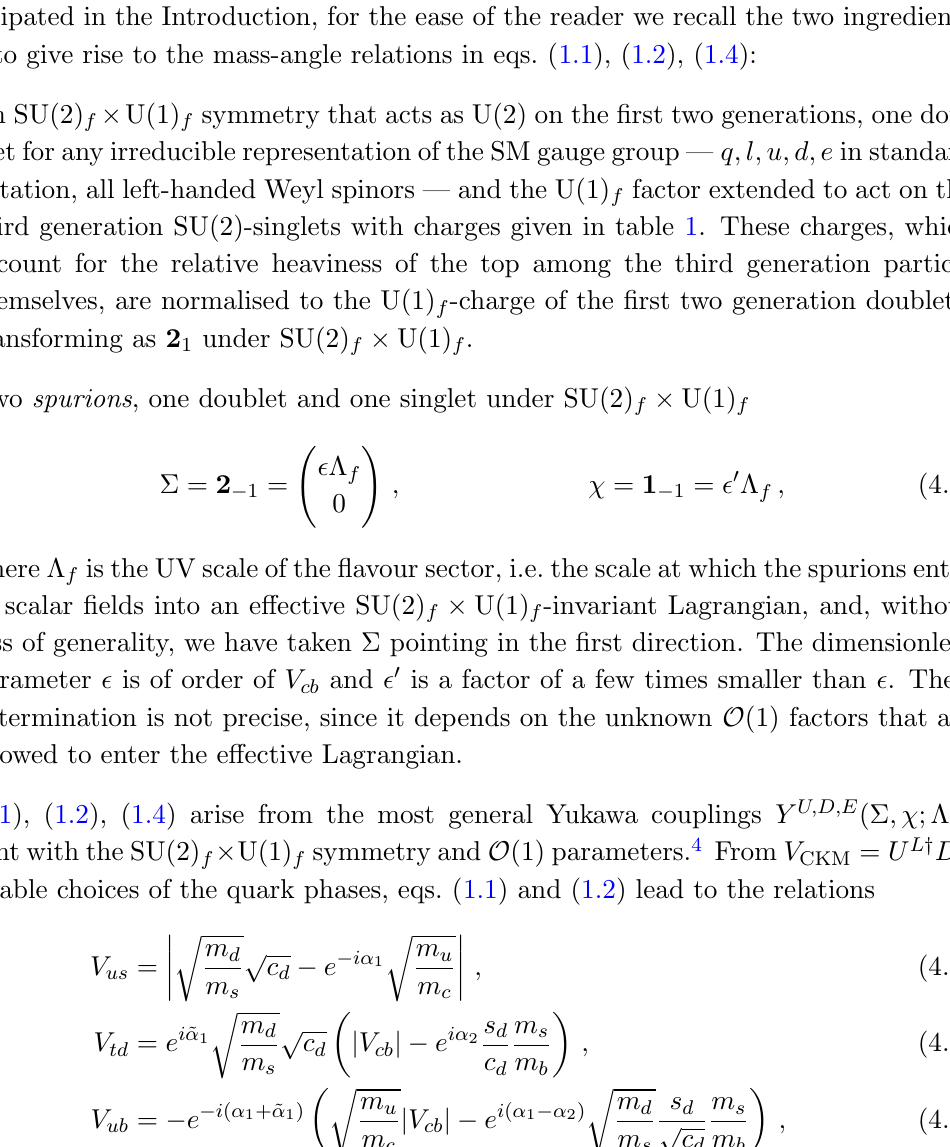
Table 1 . U(1) f charges of the third generation fermions, which are SU(2) f singlets. The (cid:12)rst two generations all transform as 2 under SU(2) f (cid:2) U(1) f 1